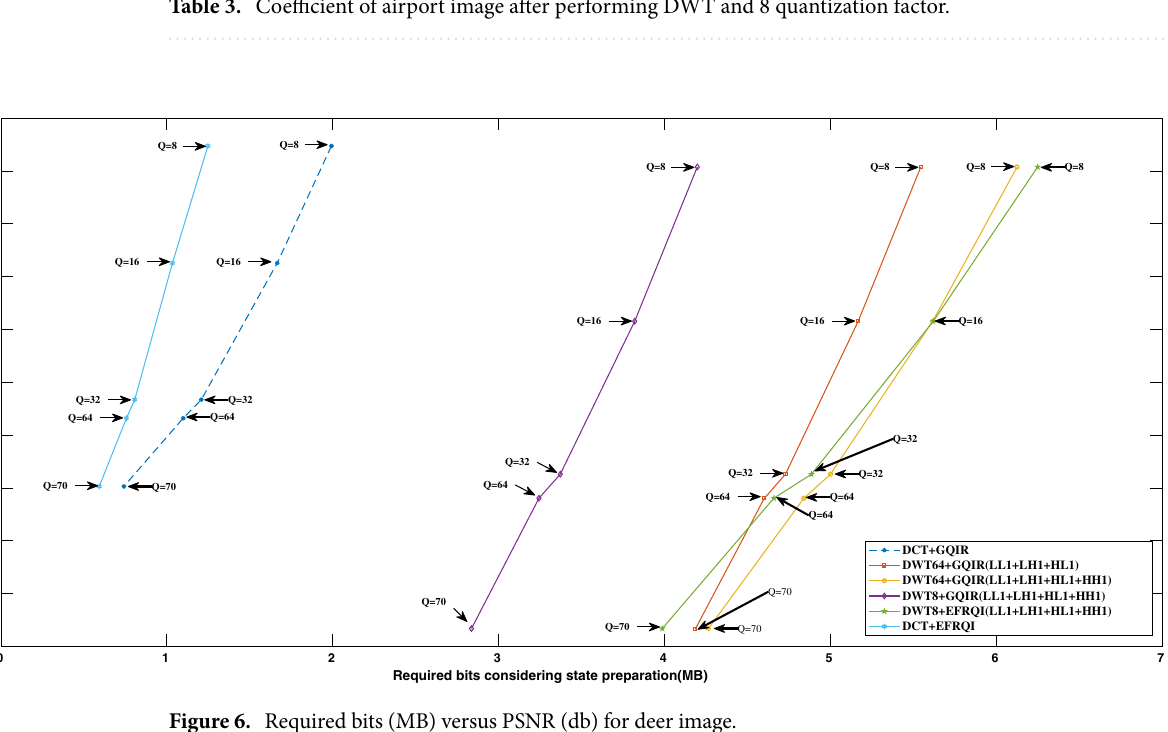
Table 3. Coefficient of airport image after performing DWT and 8 quantization factor.